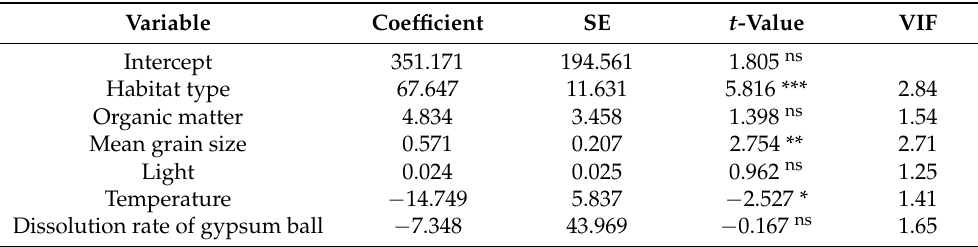
Table 3. Results of multiple regression analysis testing the influence of habitat type, organic matter, mean grain size, light, temperature, and dissolution rate of gypsum ball on the density of H. atra.